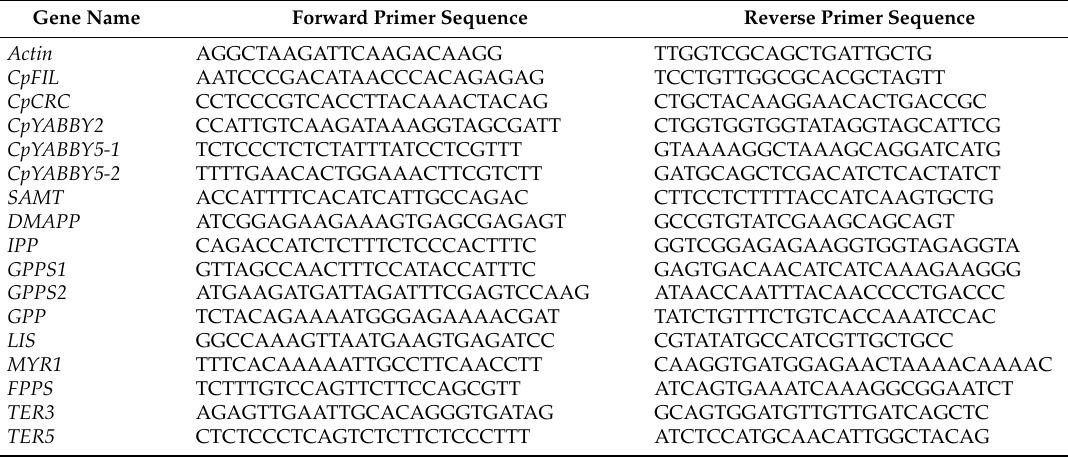
Table 1. Primer for real-time